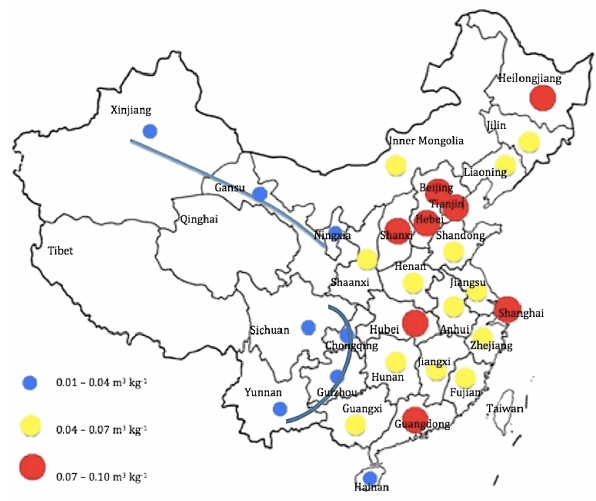
Figure 1. Indirect water of rice (m 3 kg − 1 )